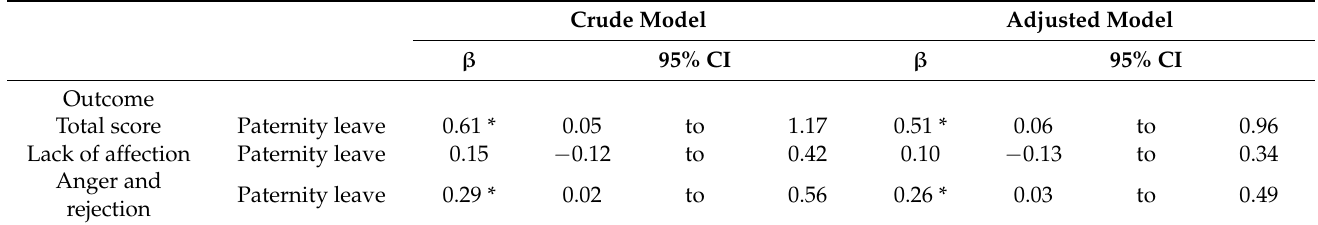
Table 3. Association of paternity leave taking and father–infant bonding